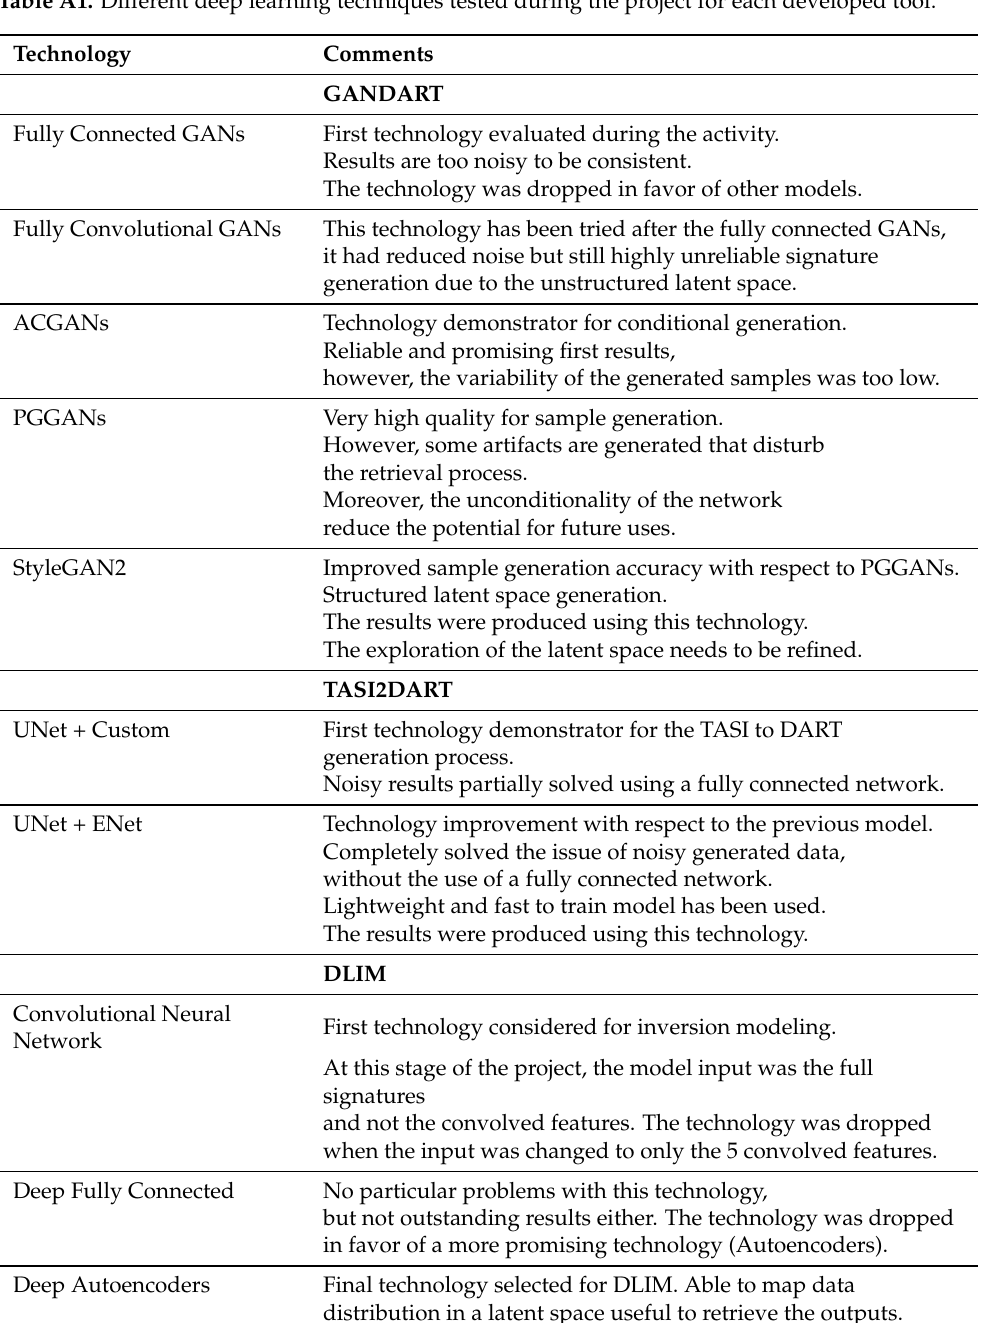
Table A1. Different deep learning techniques tested during the project for each developed